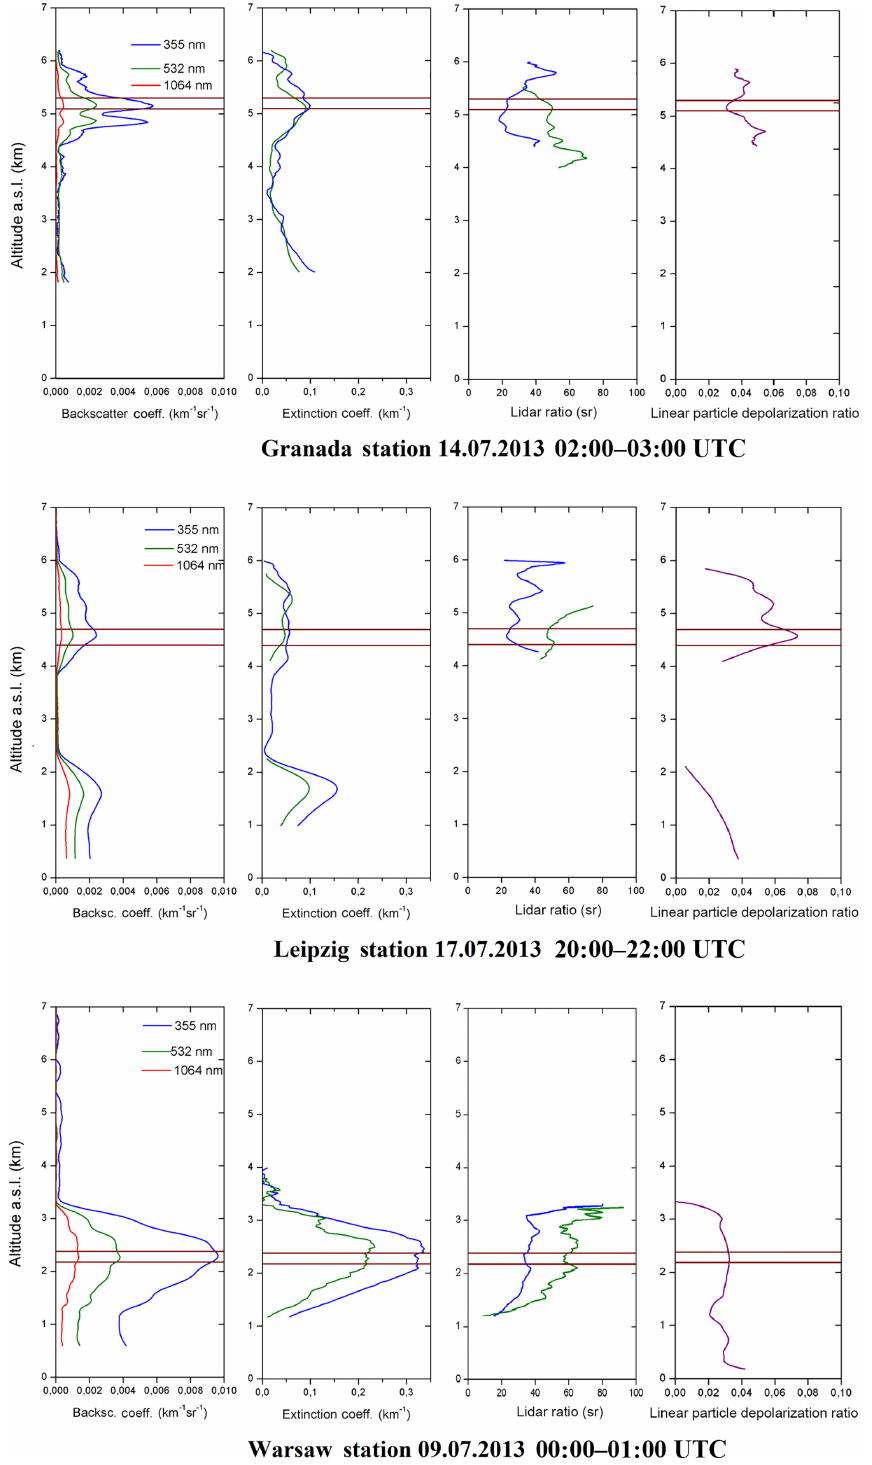
Figure 8. Vertical profiles of the particle backscatter and extinction coefficients, lidar ratio and linear particle depolarization ratio obtained for Ganada, Leipzig and Warsaw cases. The layers analyzed to obtain the optical and microphysical description of the transported particles are marked with brown